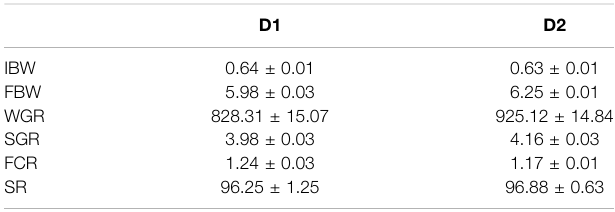
TABLE 3 | Growth performance and feed utilization of L. vannamei fed diet supplemented with/without H. pluvialis GXU-A23 for 56 days.